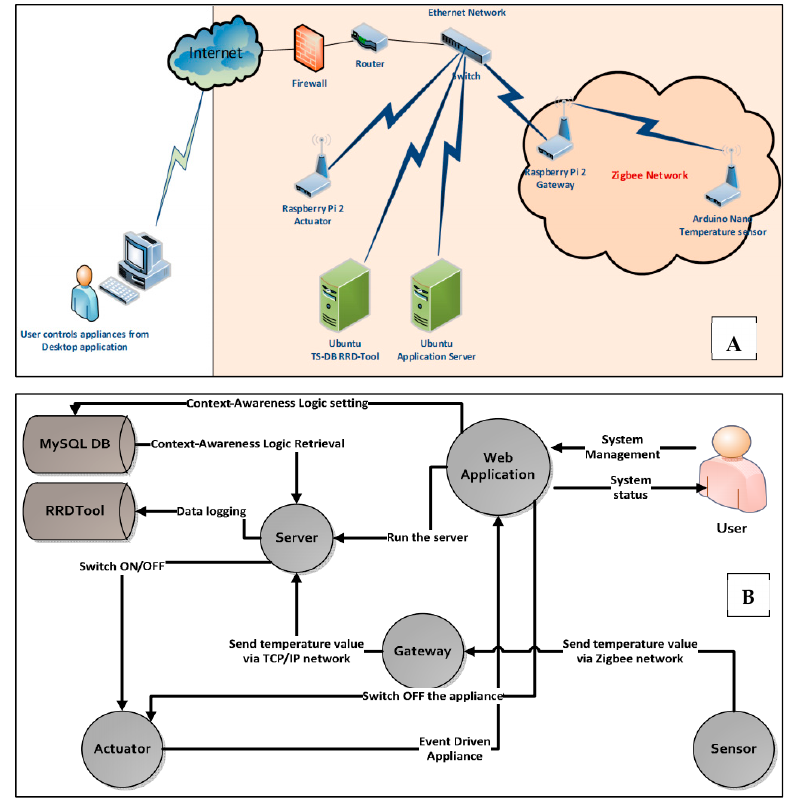
Figure 1. General architecture ( A ) and communication process ( B ) of the proposed Energy Management Systems (EMS).